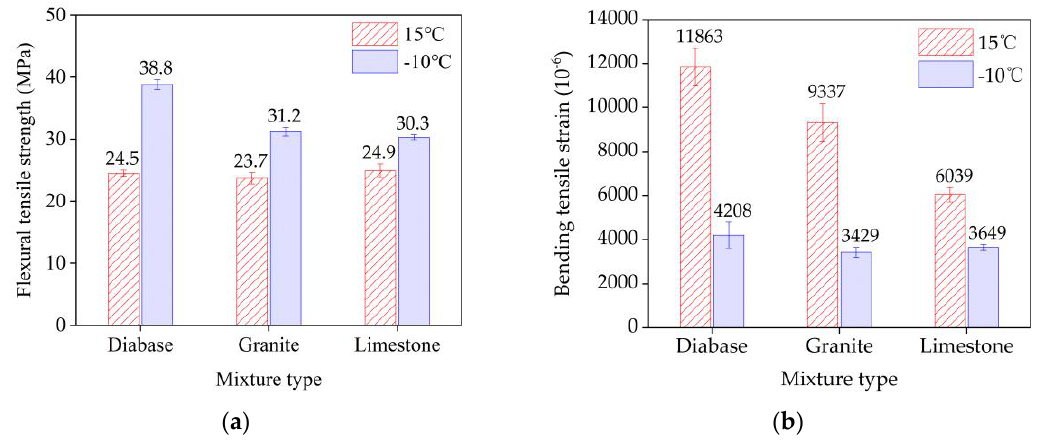
Figure 11. Three-point bending test results of three EAC beam types: ( a ) flexural tensile strength and ( b ) ultimate flexural tensile strain.